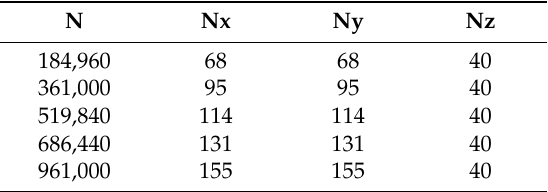
Table 1. Mesh of terrain calculated in this study.